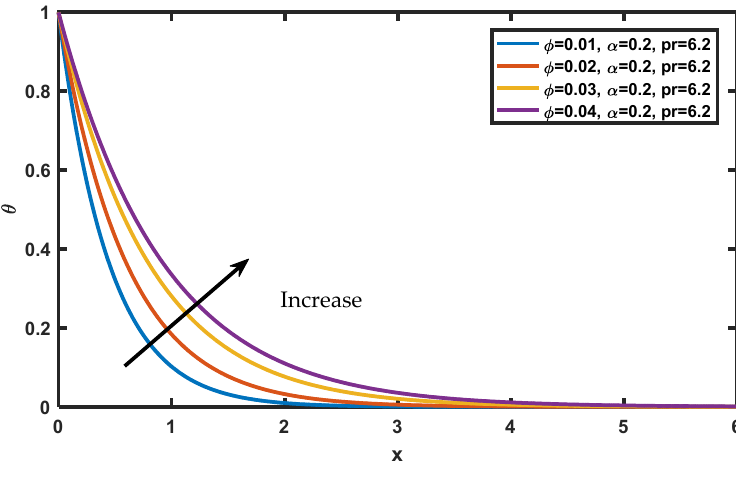
Figure 6. Variation of